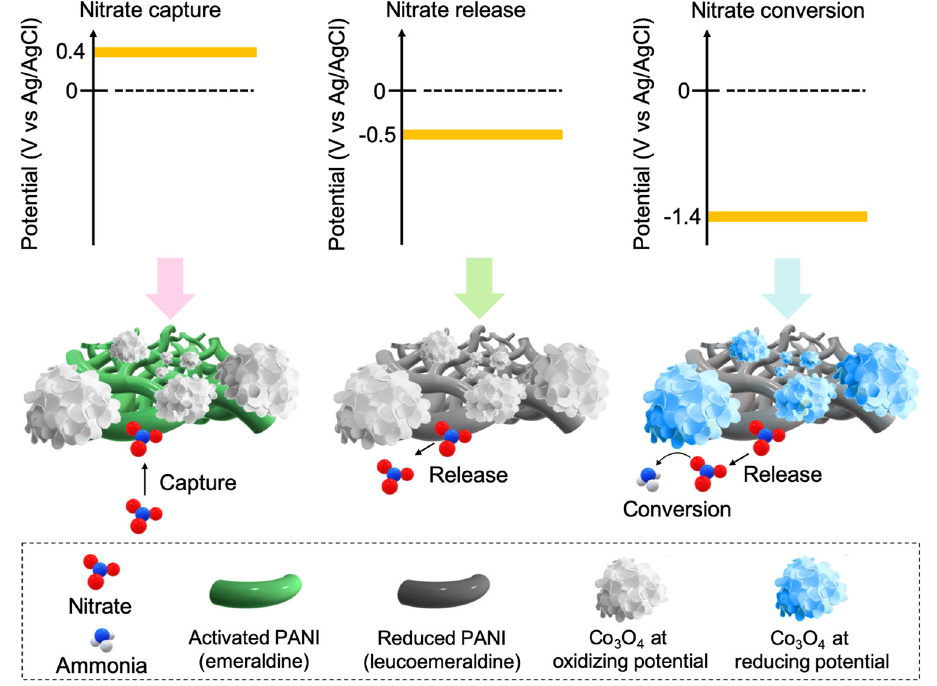
Fig. 2| SchematicillustrationofbifunctionalPANI-Co 3 O 4 /CNTelectrode. Upon anodicchargingat+0.4VvsAg/AgCl,PANIisactivated(emeraldine)andservsasan electrosorbent for nitrate. During cathodic charging, PANI is reduced to